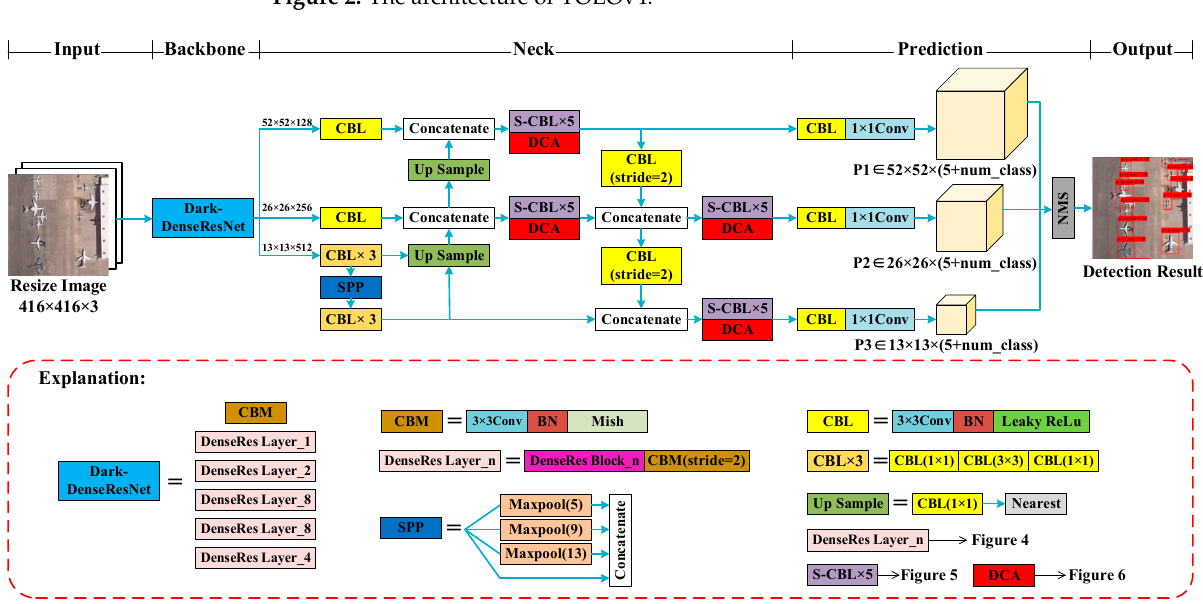
Figure 3. The architecture of YOLO-DSD.